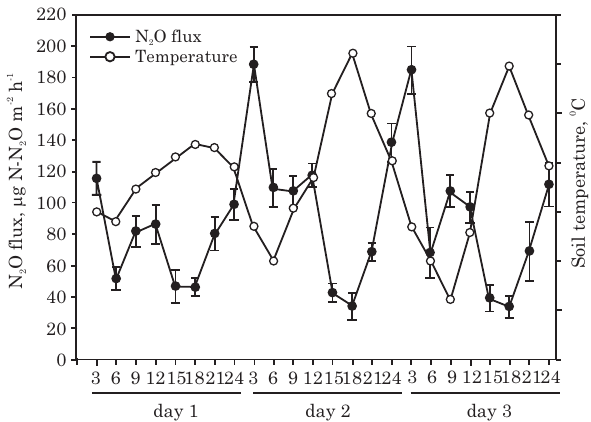
Figure 2. Soil N 2 O emission rates and soil temperature at different times of the day. Bars indicate standard errors of the mean.